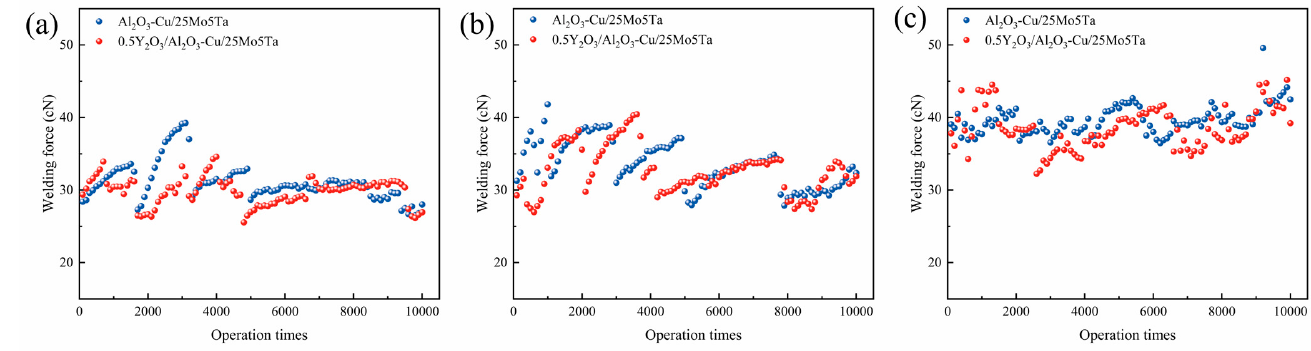
Figure 5. Variation of welding force with the operation times for Al 2 O 3 -Cu/25Mo5Ta and 0.5Y 2 O 3 /Al 2 O 3 -Cu/25Mo5Ta electrical contact materials: ( a ) 10 A; ( b ) 20 A; ( c ) 30 A.